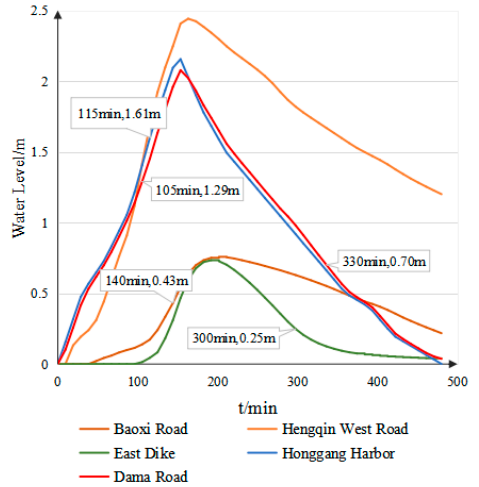
Figure 12. Water-level variation curve at typical locations.